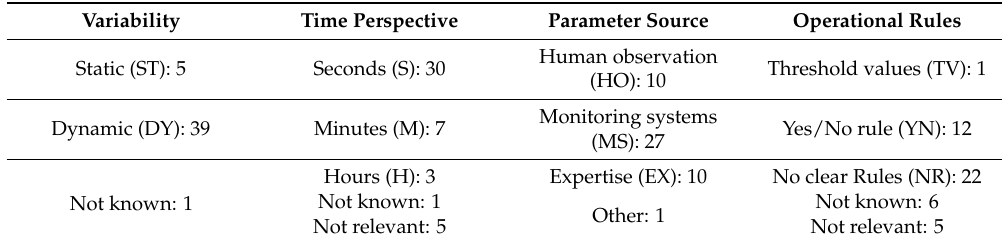
Table 7. Summary table of information parameters, coded with EQD information attributes (note that some parameters belong to more than one category, so the sum for each category may be larger than 45). Variability Time Perspective Parameter Source Operational